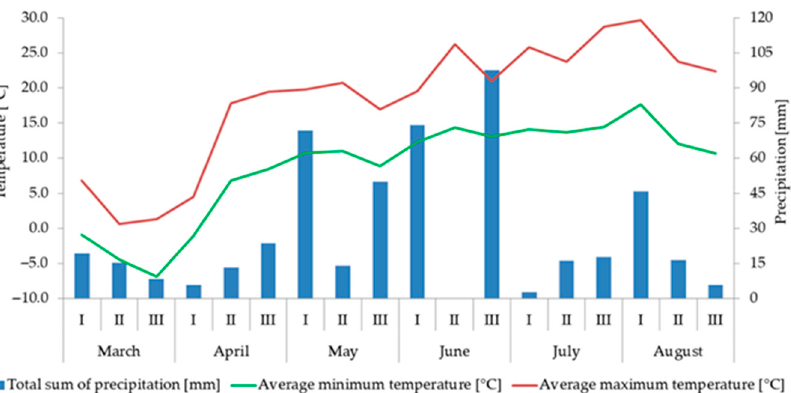
Figure 3. Decade weather condition in 2013 marking minimum and maximum temperature and precipitation in decades.